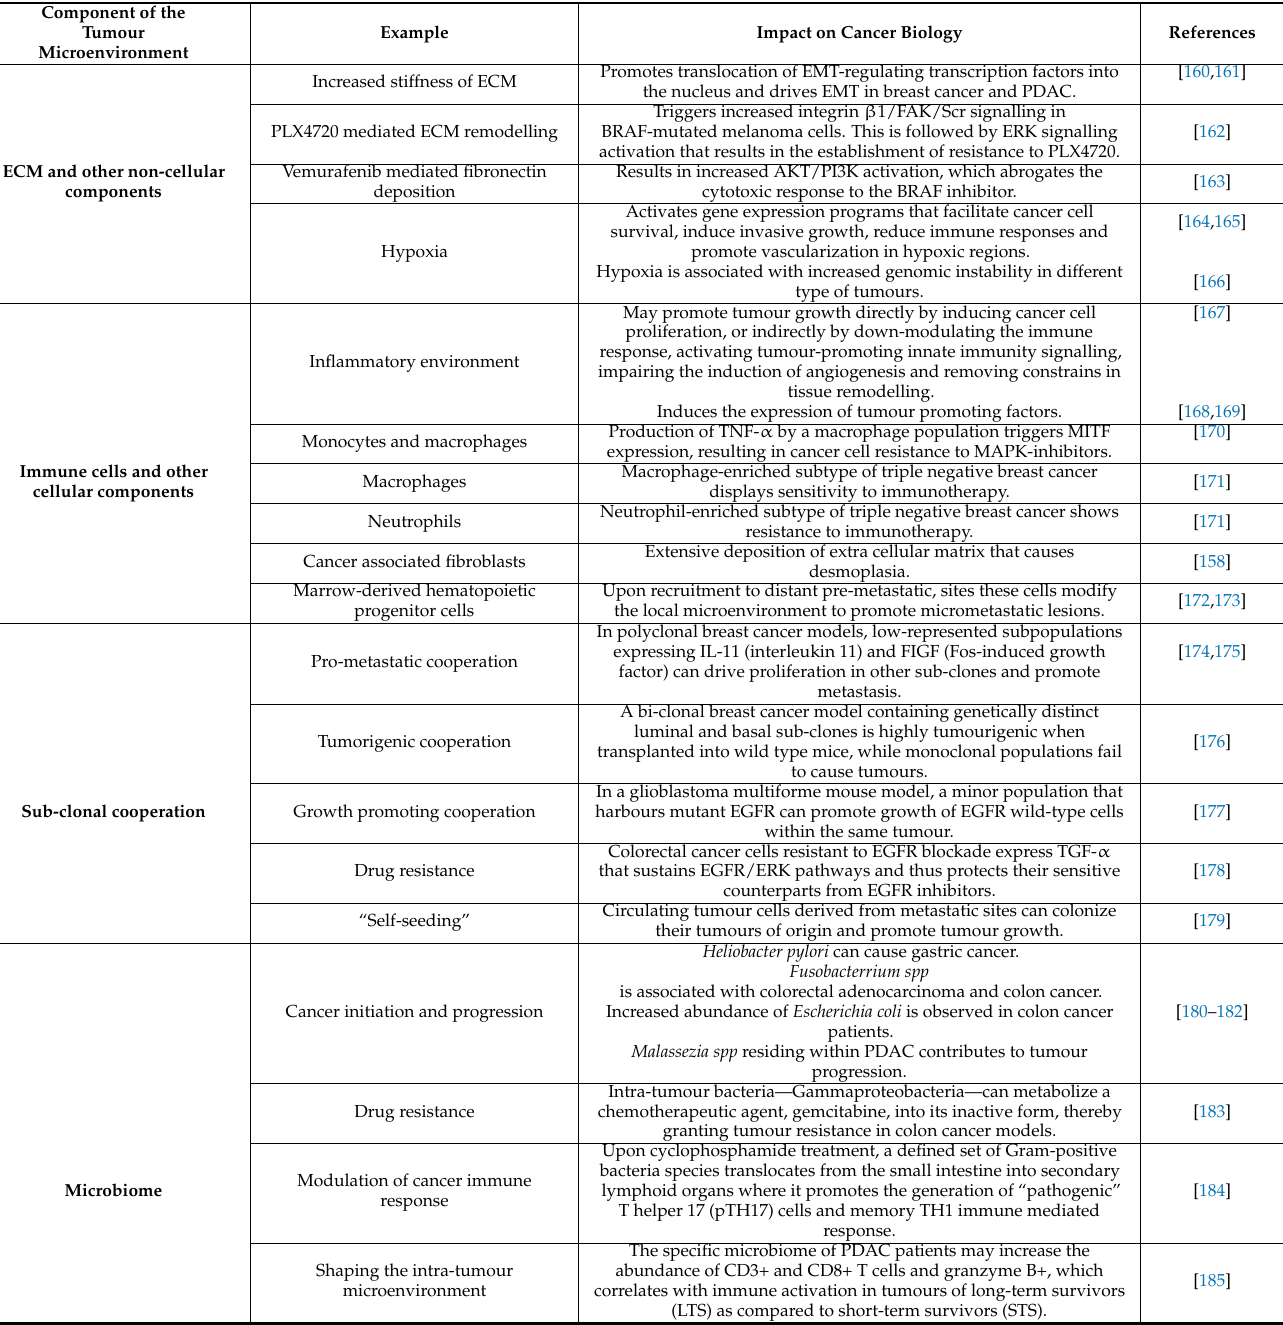
Table 1. Role of tumour microenvironment in cancer